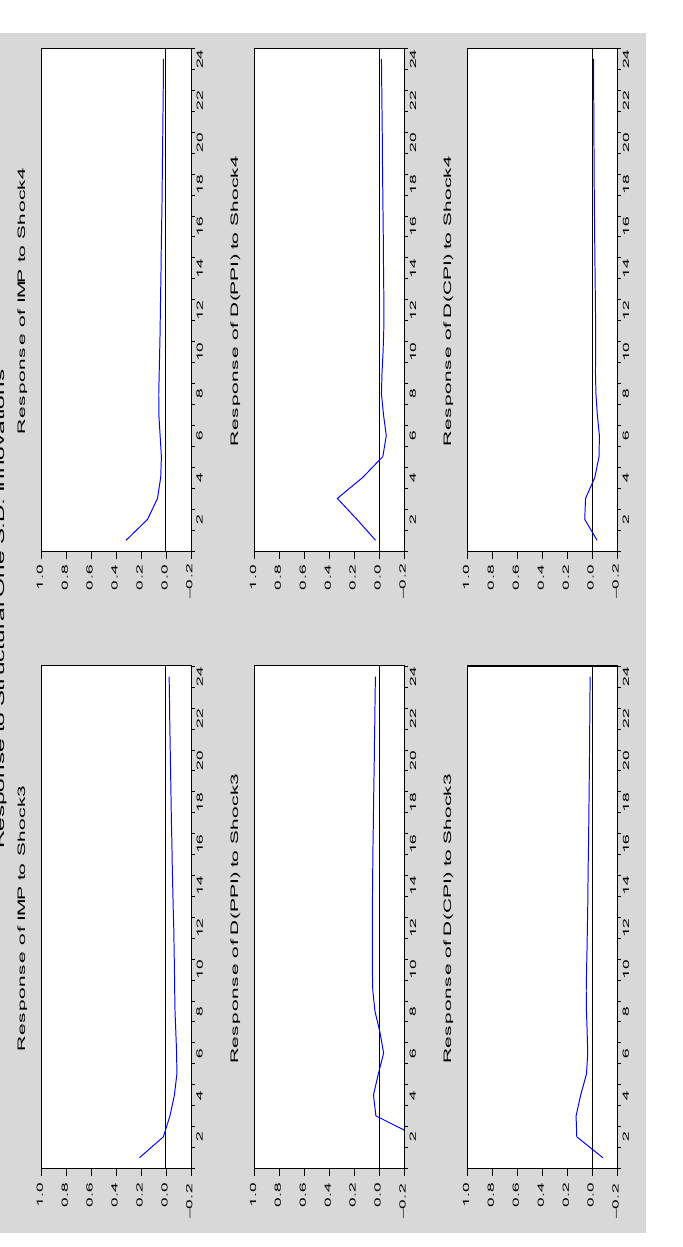
Figure 3. Impulse Responses